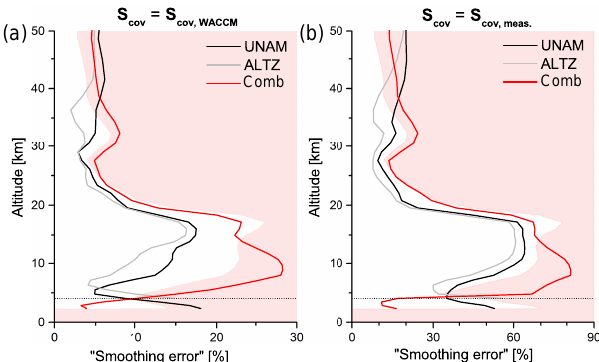
zomoni data (grey line), reflecting their better vertical reso-